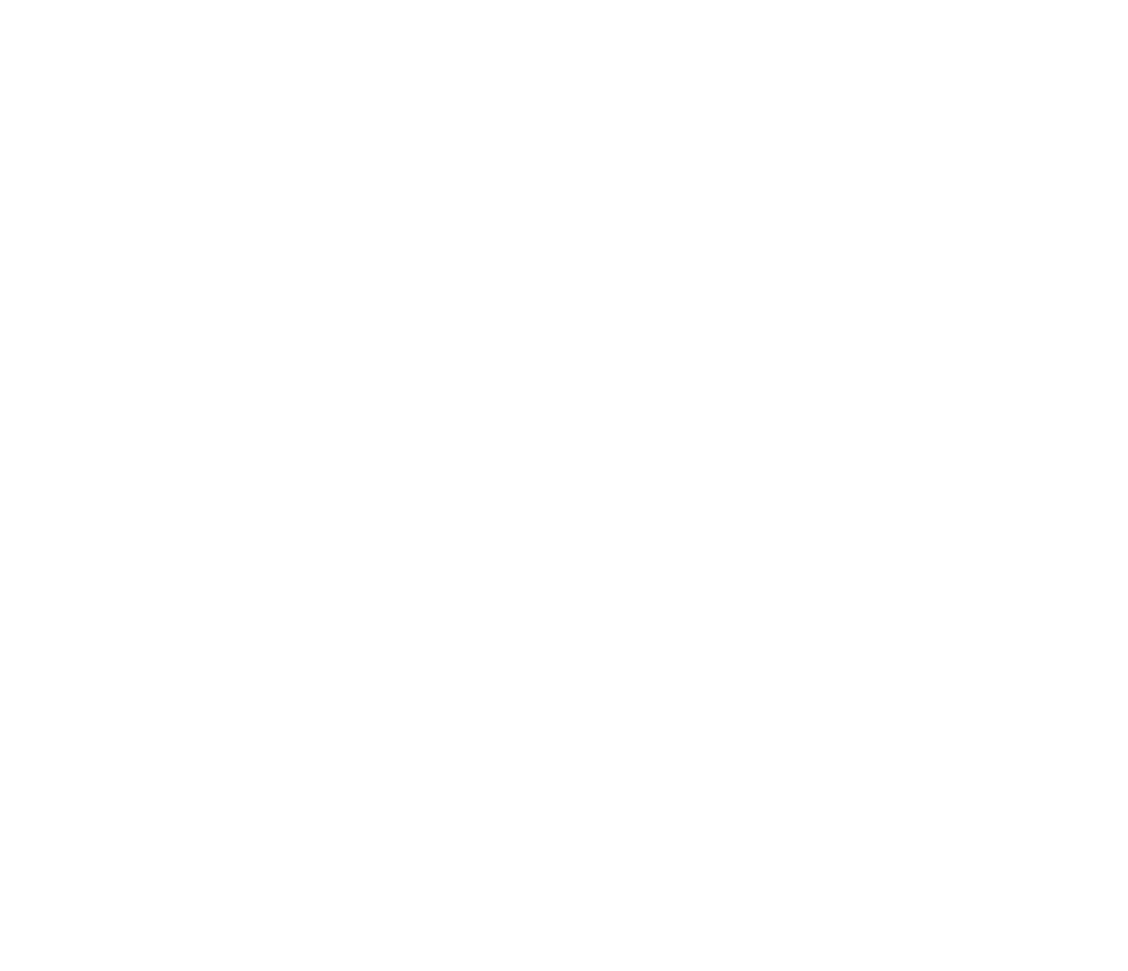
Frontiers in Pharmacology |